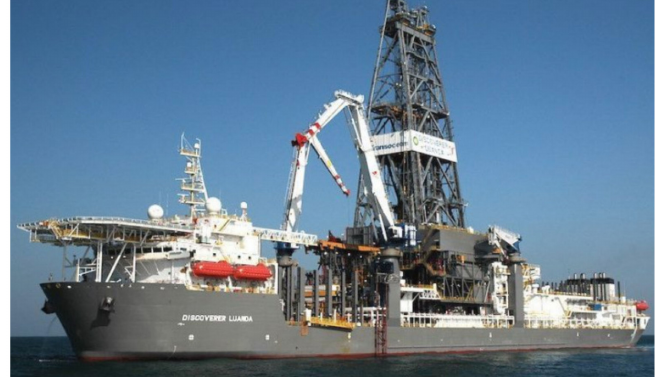
Figure 11. DrillShip semisubmersible (Courtesy: Transocean).